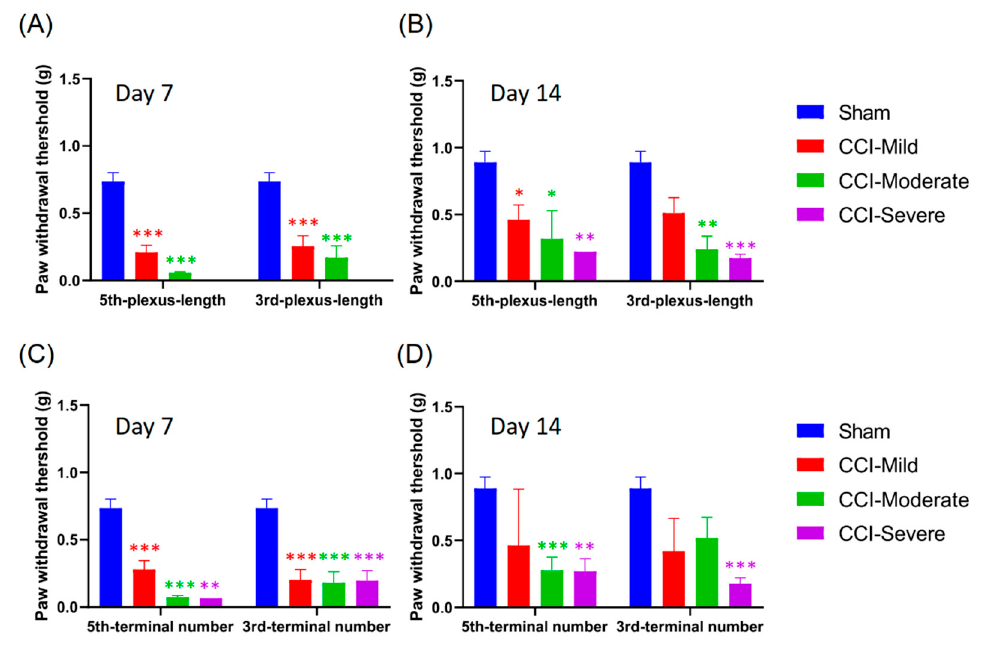
Figure 8. Association between mechanical threshold and the indices of the sub-epidermal nerve plexus and nerve terminals in the third and fifth toe tips. ( A , B ) Index of plexus length in the toe tips is associated with the mechanical threshold. The CCI-mild group showed mechanical hypersensitivity at 7 d when indexed by the third toe tip and at both 7 and 14 d when indexed by the fifth toe tip. The CCI-moderate group, indexed by either the third or the fifth toe tip, showed mechanical hypersensitivity at both 7 and 14 d after CCI surgery. The CCI-severe group, whether indexed by plexus length in the third or fifth toe tip, showed mechanical hypersensitivity only at 14 d. ( C , D ) The index of the number of nerve terminals in the toe tips is associated with mechanical threshold. The CCI-mild group showed mechanical hypersensitivity when indexed by number of terminals in the third or fifth toe at 7 d but not at 14 d. The CCI-moderate group indexed by the third toe showed mechanical hypersensitivity at 7 d, while the group indexed by the fifth toe showed hypersensitivity at both 7 and 14 d. The CCI-severe group, whether indexed by the third or the fifth toe, showed hypersensitivity at both 7 and 14 d. * p < 0.05, ** p < 0.01 and *** p < 0.001, compared to the sham group. 3.9. Indexing by the Relative Length and Number of Nerves Remaining at 7 D Post CCI Was Associated